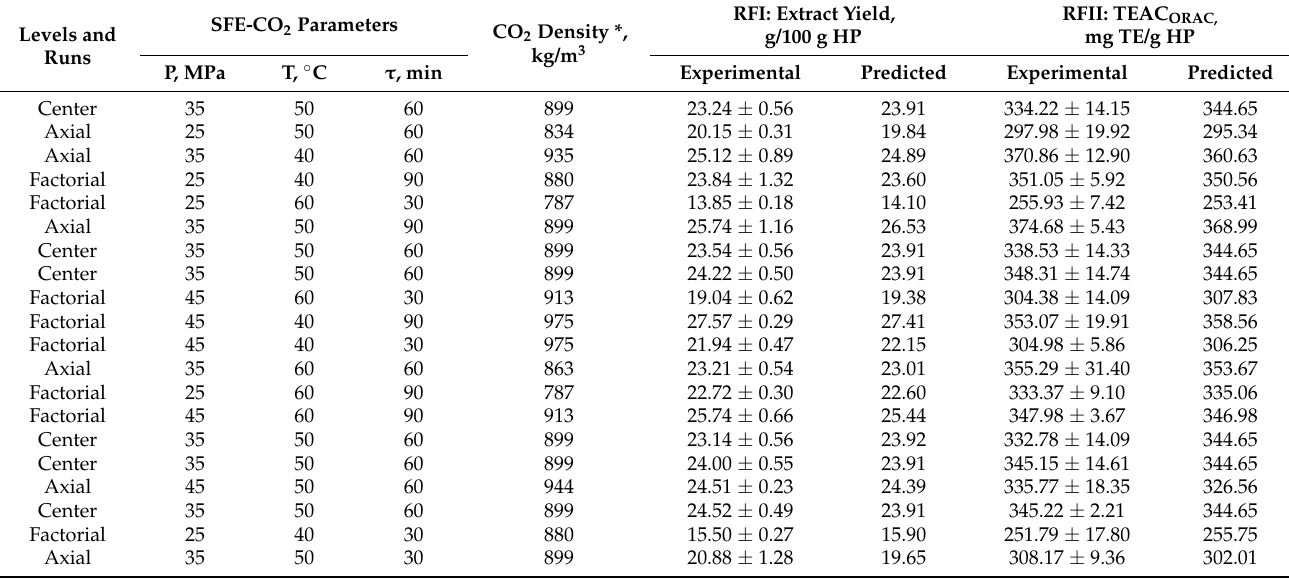
RFII: TEAC ORAC, mg TE/g